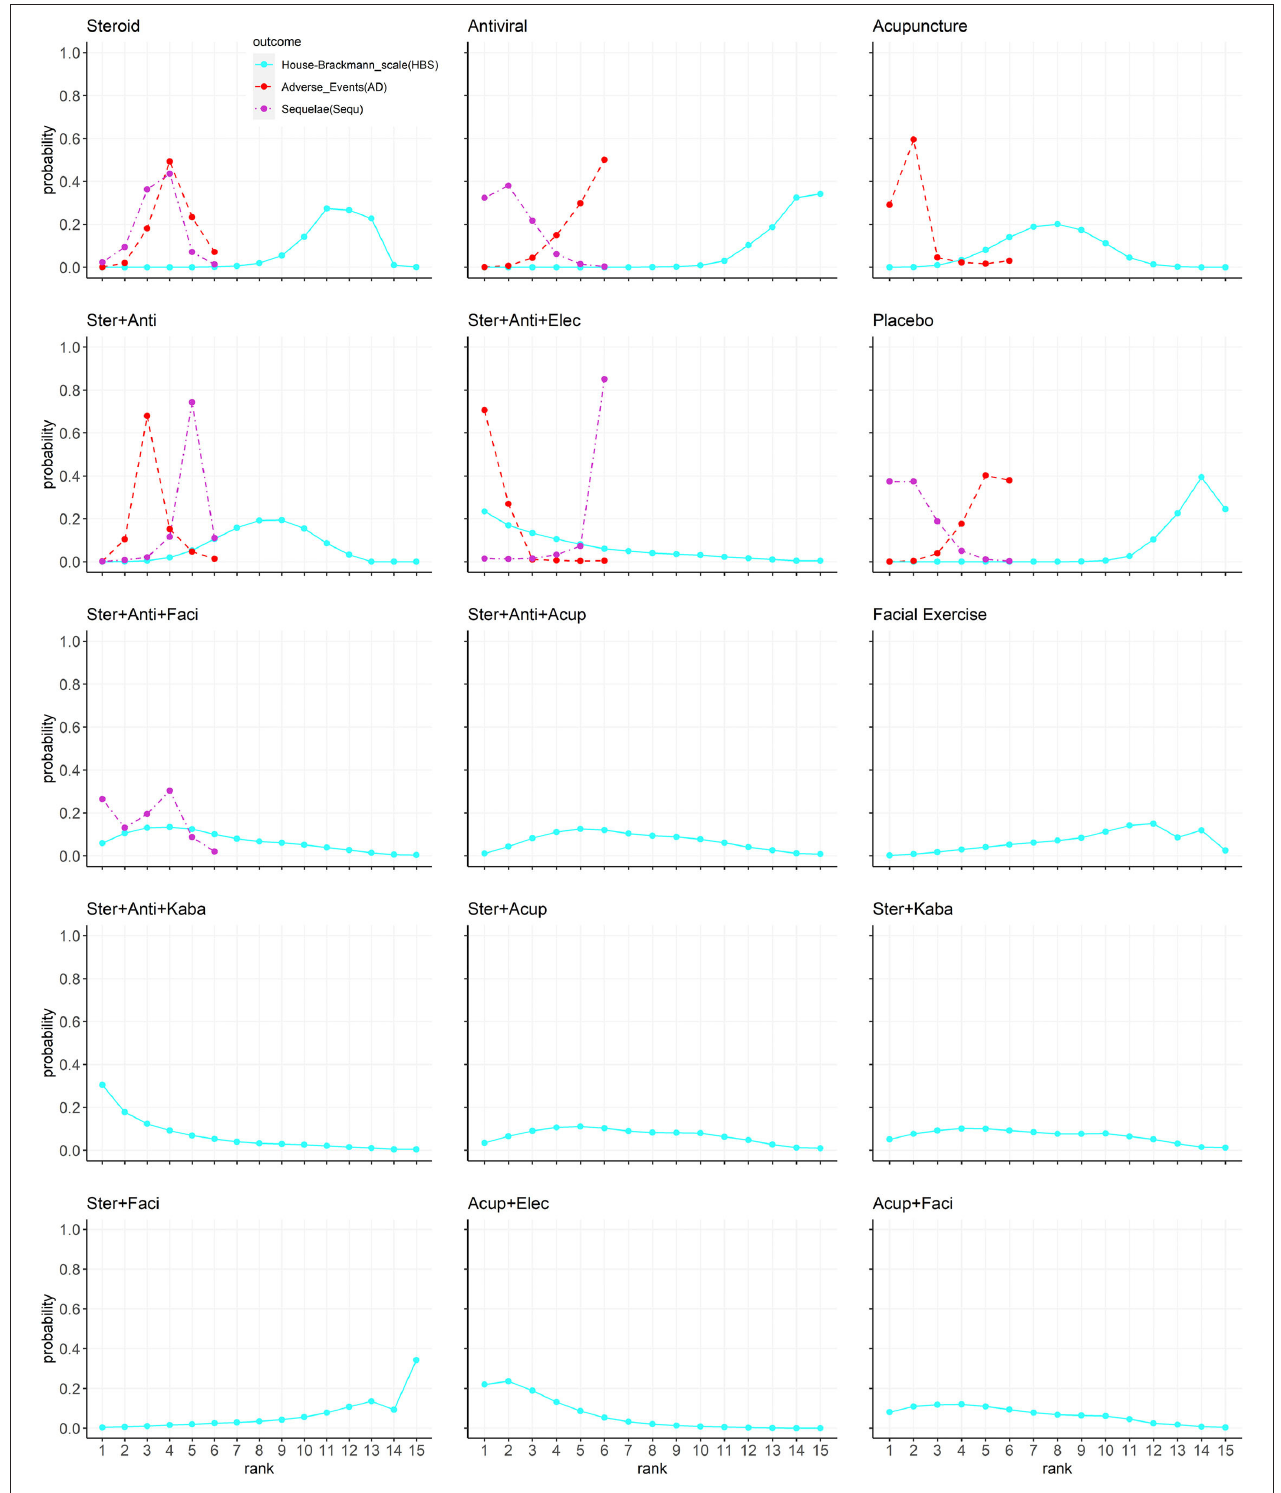
FIGURE 3 | The Bayesian ranking profiles of comparable treatments on efficacy for patients with Bell’s palsy according to House–Brackmann rating scale. Profiles indicate the probability of 15 comparable treatments being ranked from first to last on facial recovery (blue), adverse events (red), and sequelae (purple). Ranking curves are described according to the Bayesian ranking results presented in Supplementary Table 2 (Ster, Steroid; Anti, antiviral; Kaba, Kabat treatment; Elec, Electrical stimulation; Acup, Acupuncture; Faci, Facial exercise).